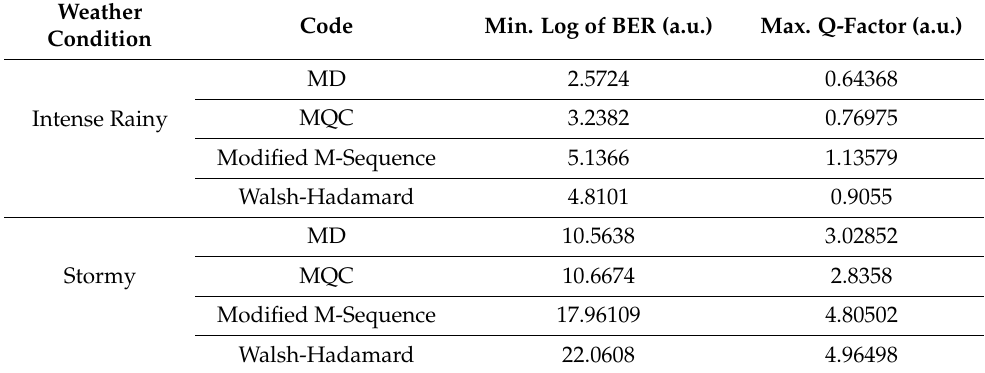
Figure 13. Performance of the system in stormy weather condition for the AWGN and turbulence-induced fading channel: ( a ) min. log of BER; ( b ) max. Q-factor. Table 6. Performance degradation with an increasing FSO range in the AWGN and turbulence- induced fading channel. Code Min. Log of BER (a.u.) Max. Q-Factor